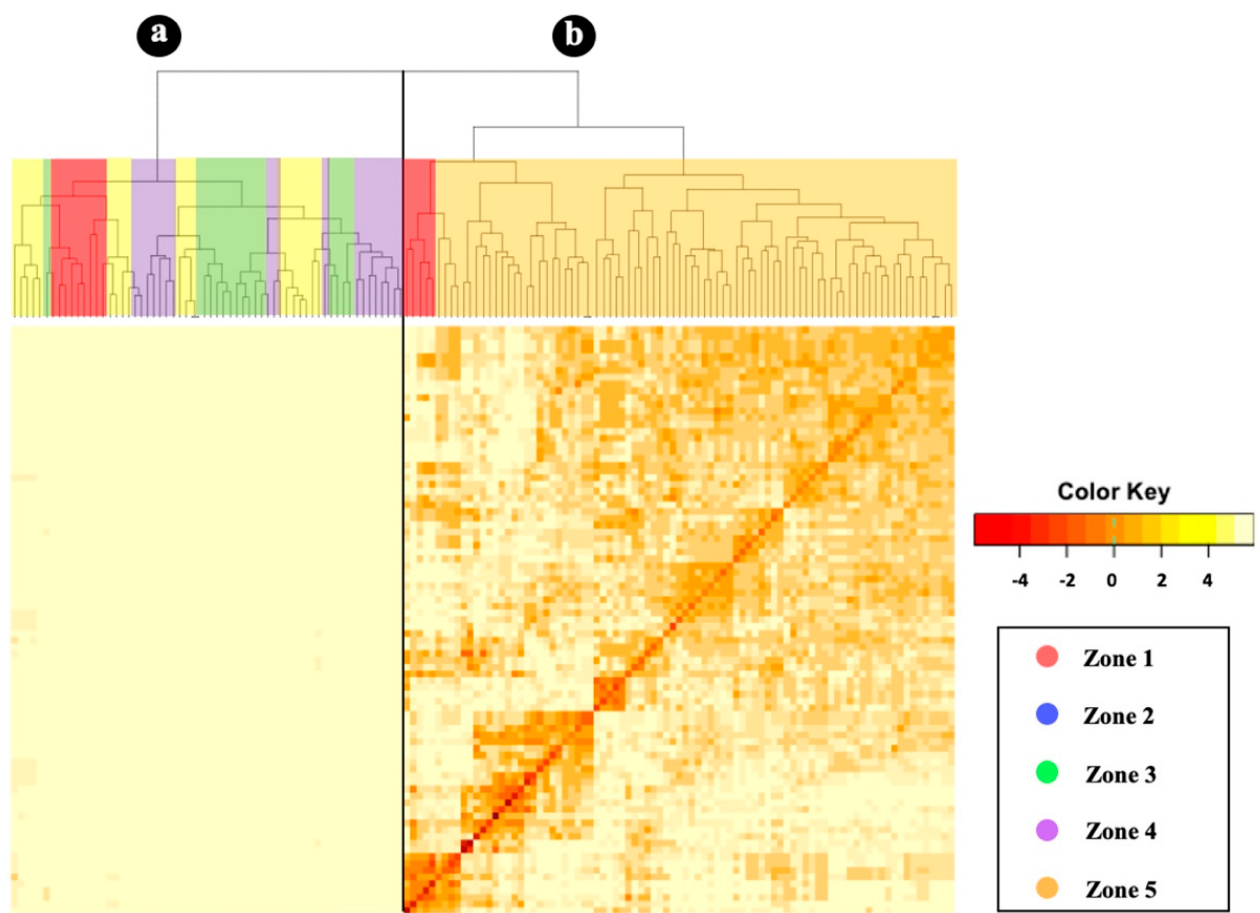
Figure 2. Kinship relatedness among leatherback turtle populations. Samples were categorized into two groups: all zones except Zone 5 (Bang Kwan Beach) ( a ); and Zones 1 (Khuk Khak Beach) (11.5%) and 2 (Bang Kwan Beach) (88.5%) ( b ).